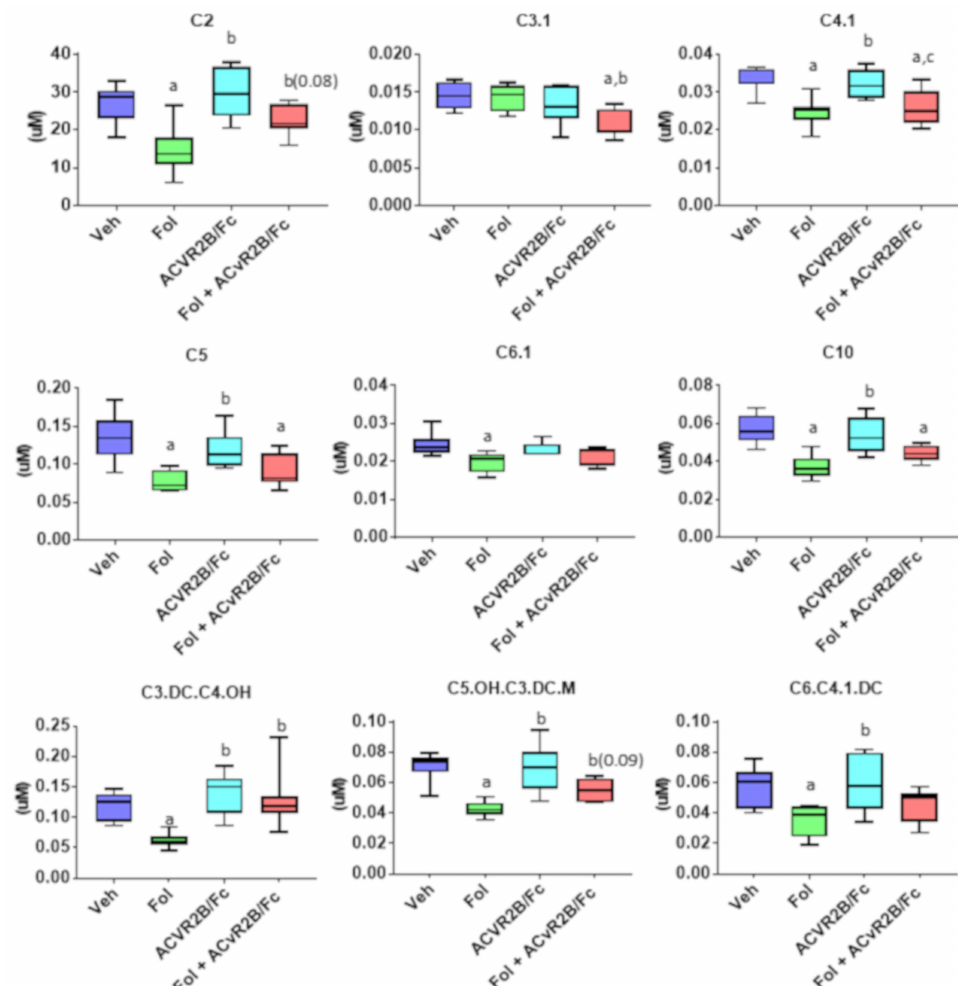
Figure 5. Serum levels of acylcarnitines showing at least one significant inter-group di ff erence. Significance di ff erences include p -values < 0.05 for a vs. Veh, b vs. Folfiri, c vs. ACVR2B / Fc. C2, acetylcarnitine; C3.1, propenoylcarnitine; C4.1, butenylcarnitine; C5, valerylcarnitine; C6.1, hexenoylcarnitine; C10, decanoylcarnitine; C3.DC.C4.OH, hydroxybutyrylcarnitine; C5.OH.C3.DC.M, hydroxyvalerylcarnitine; C6.C4.1.DC,